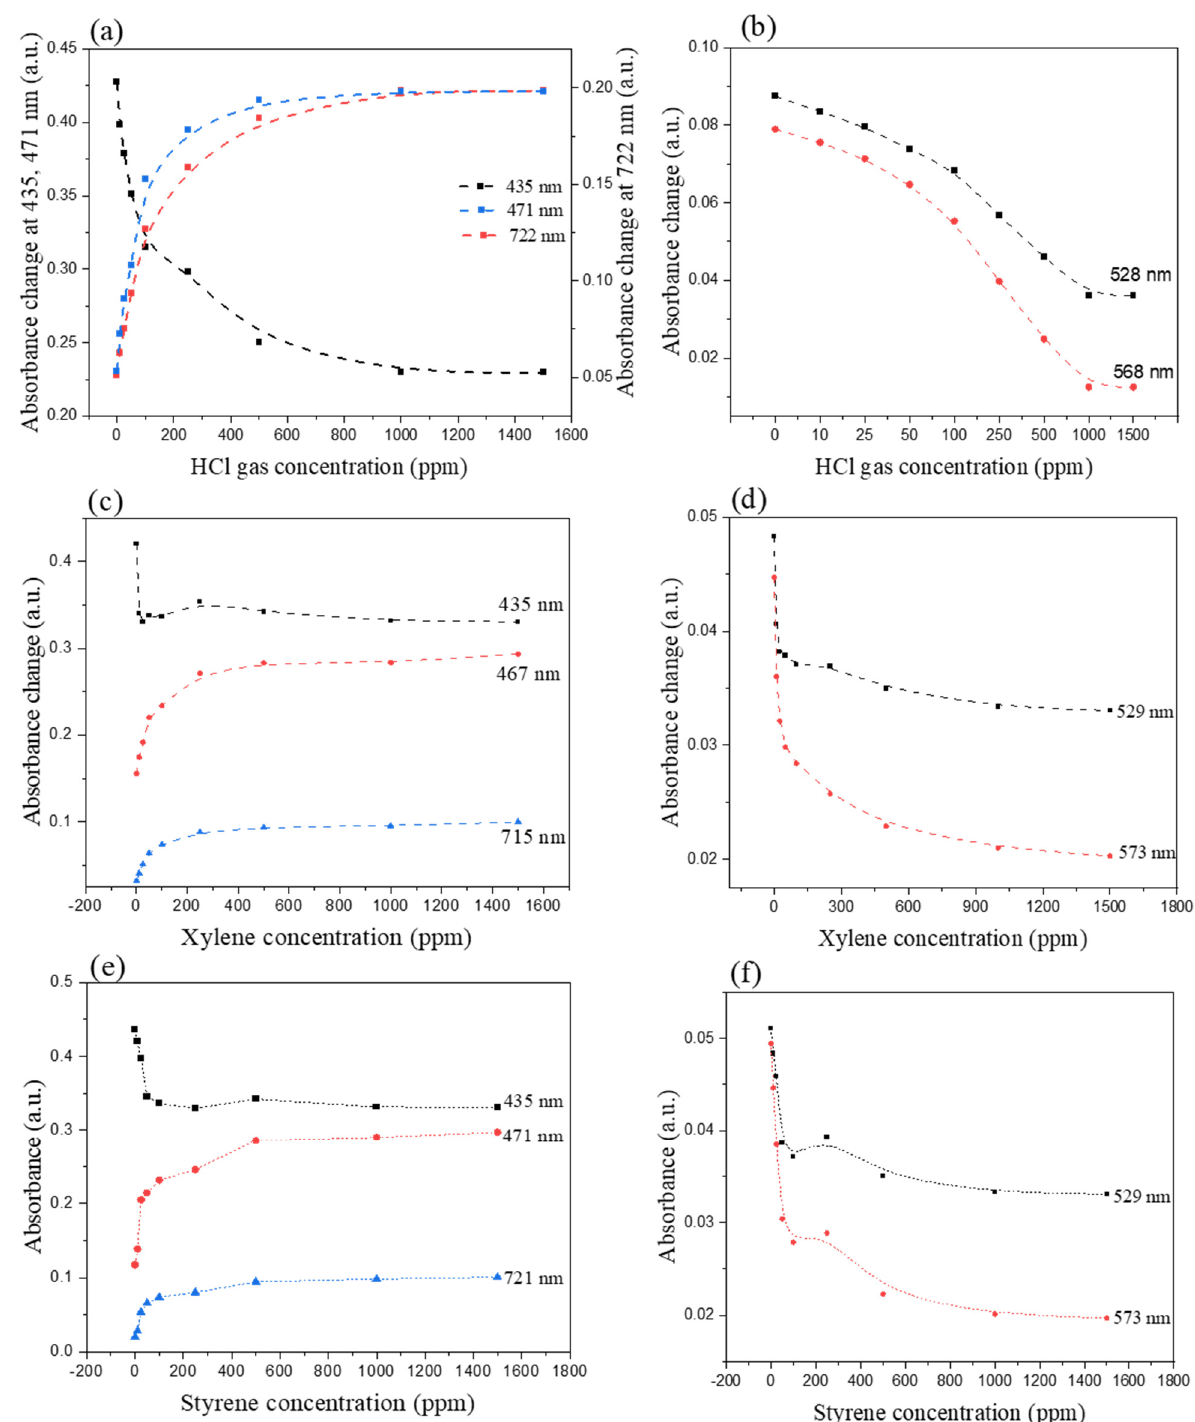
Figure 9. Linearity between absorbance change along with HCl gas concentration in UV-Vis absorption spectrum of PPc film interacting with ( a,b ) HCl vapor (10 ppm to 1500 ppm); ( c,d ) m-xylene vapor (10 ppm to 1500 ppm); ( e,f ) styrene vapor (10 ppm to 1500 ppm).